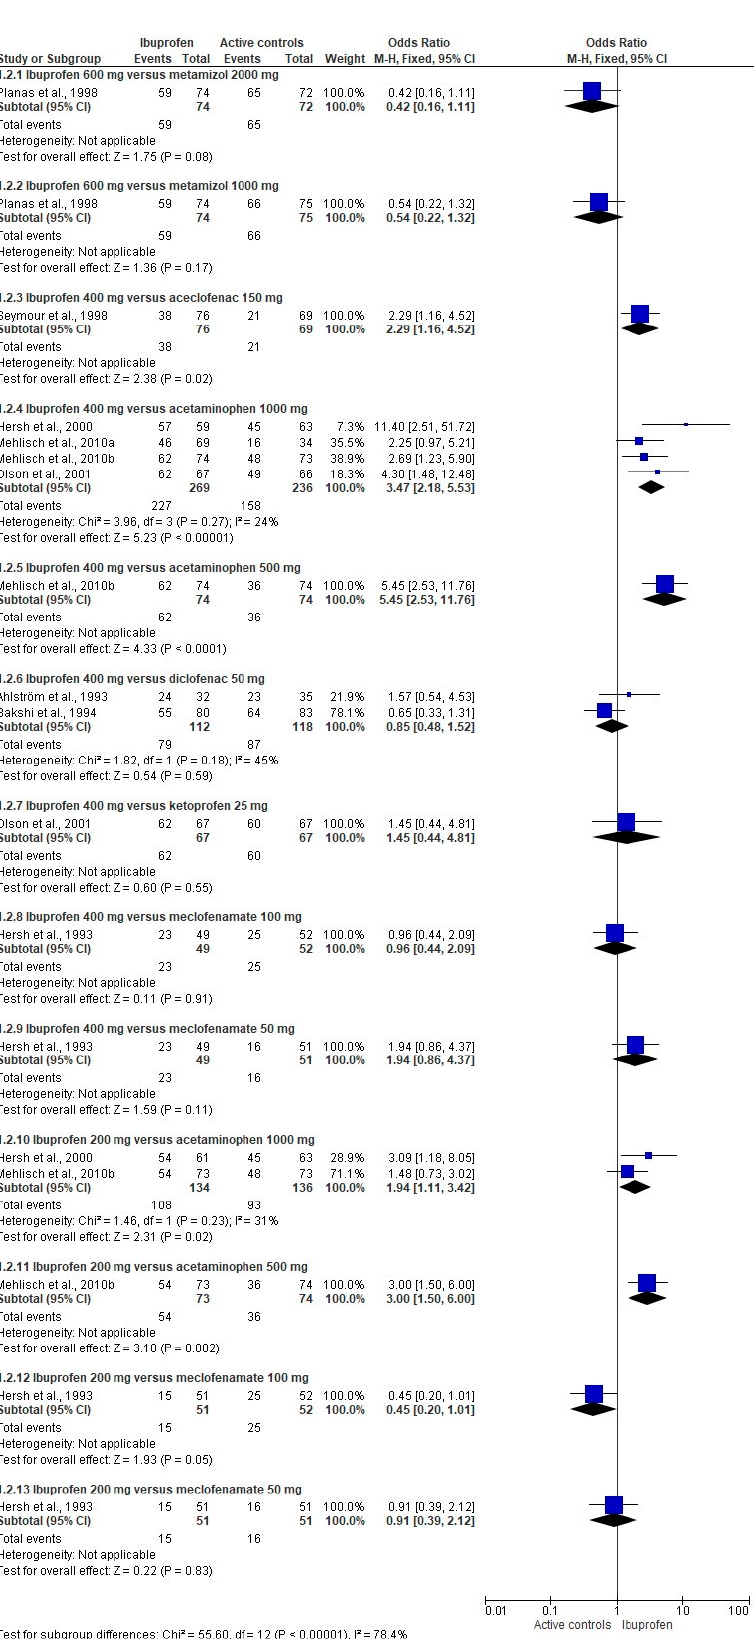
Figure 4. Combined analysis of the overall evaluation of the study medication following wisdom teeth surgery.